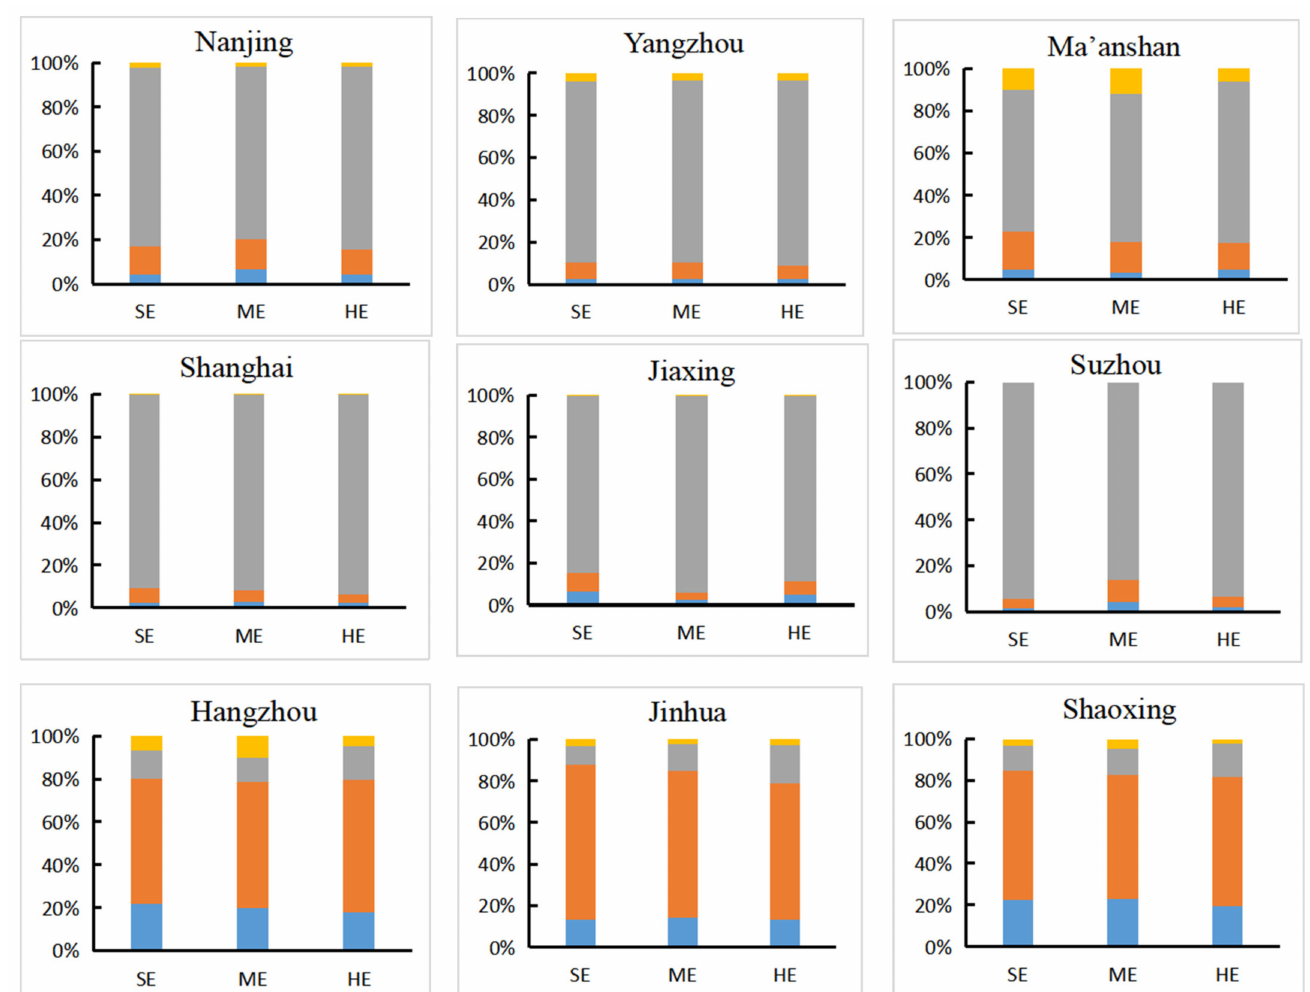
Figure 10. Changes in major causes of carbon